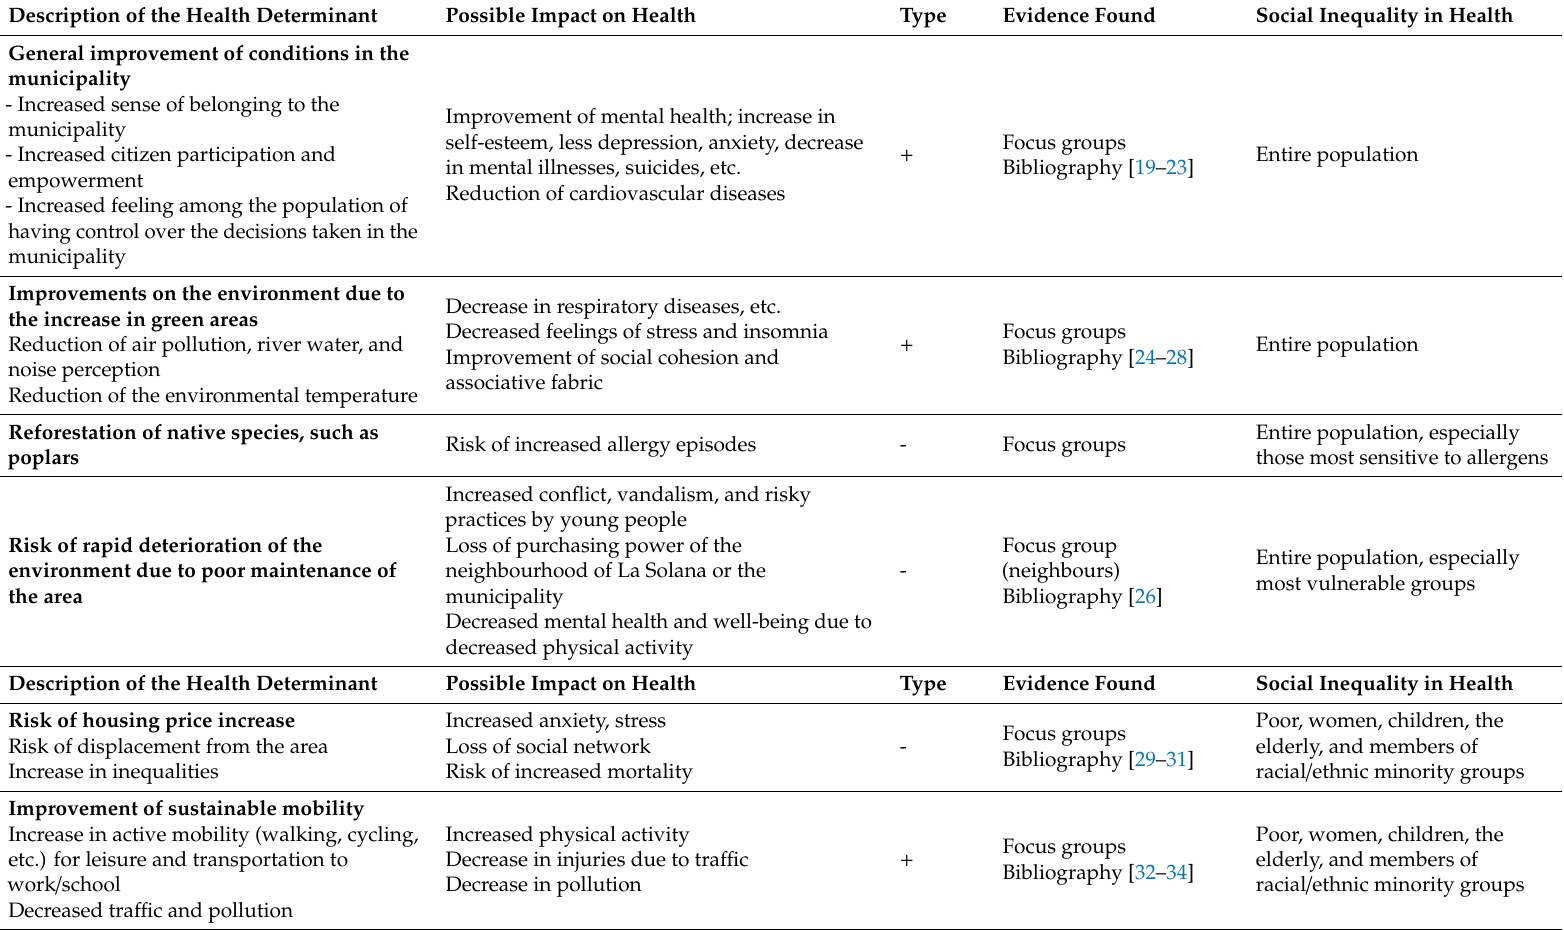
Table 2. Impact analysis